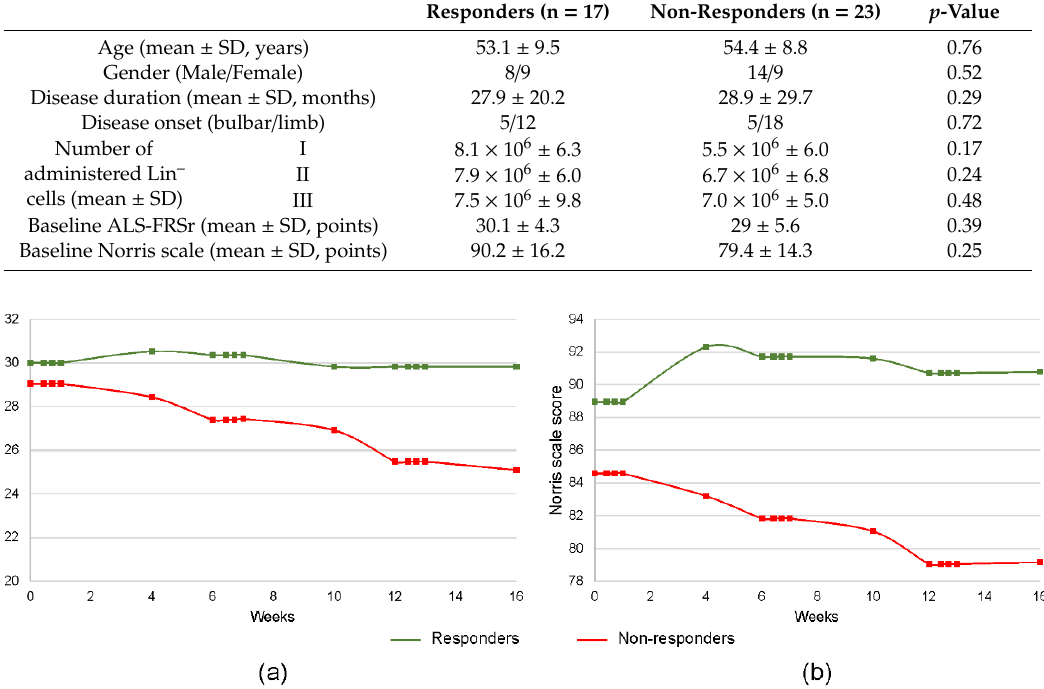
Table 1. Patients’ characteristics. Responders—patients whose functional condition assessed using amyotrophic lateral sclerosis (ALS) Functional Rating Scale (ALS-FRSr) did not deteriorate by more than 1 point during the observation period. Non-responders—patients whose results in ALS-FRSr were lower on the 28th day after the last administration of Lin – cells by 2 or more points than before the first procedure.